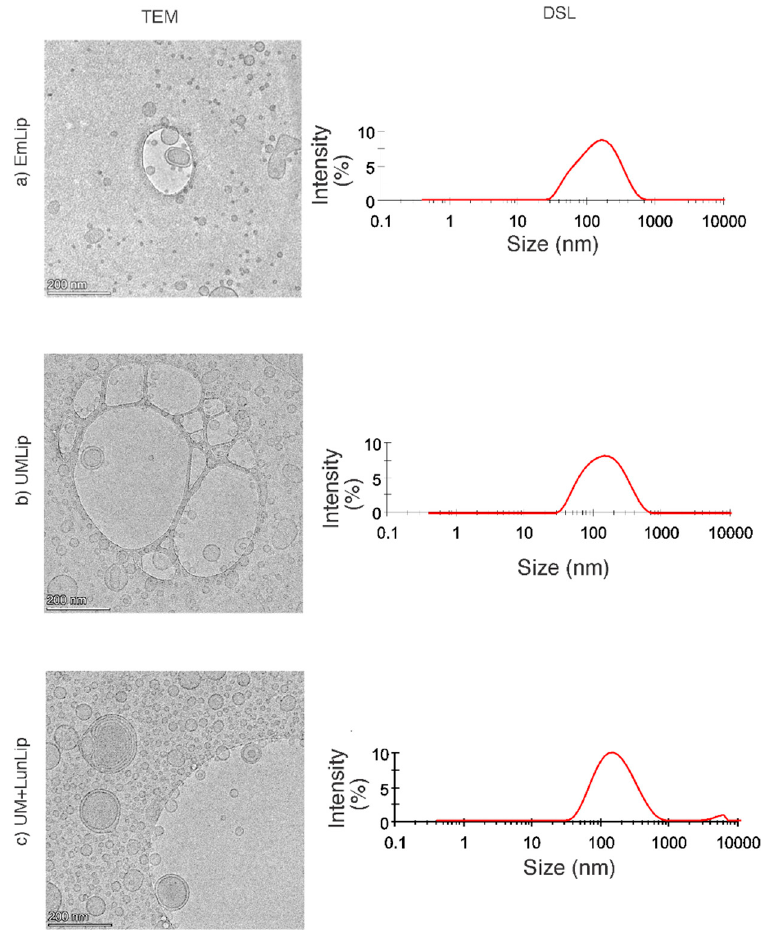
Figure 1. Transmission electron microscopy (TEM) micrographs and particle size distribution from dynamic light scattering (DSL): ( a ) empty liposomes (EmLip); ( b ) liposomes loaded with amaranth unsaponifiable matter (UMLip, 1.10 mg/mL) containing DOPC-DOPG 15.27 mg/mL; and ( c ) lipo- somes loaded with unsaponifiable matter (1.10 mg/mL) and soybean lunasin (4 mg/mL). The bilayer of all the liposomes contained dioleoyl phosphatidylcholine (DOPC)/dioleoyl phosphatidyl glycerol (DOPG) 15.27 mg/mL. Bars = 200 nm. The larger structures are part of the holey carbon film, which contains unobstructed regions to reduce noise from the background. A picture of the holey carbon coat can be found at the supplier’s website: https://www.2spi.com/category/grids-custom-holey- carbon/, accessed 17 August 2022.